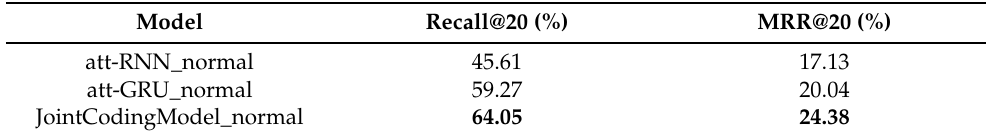
Table 5. Experimental results of the normal